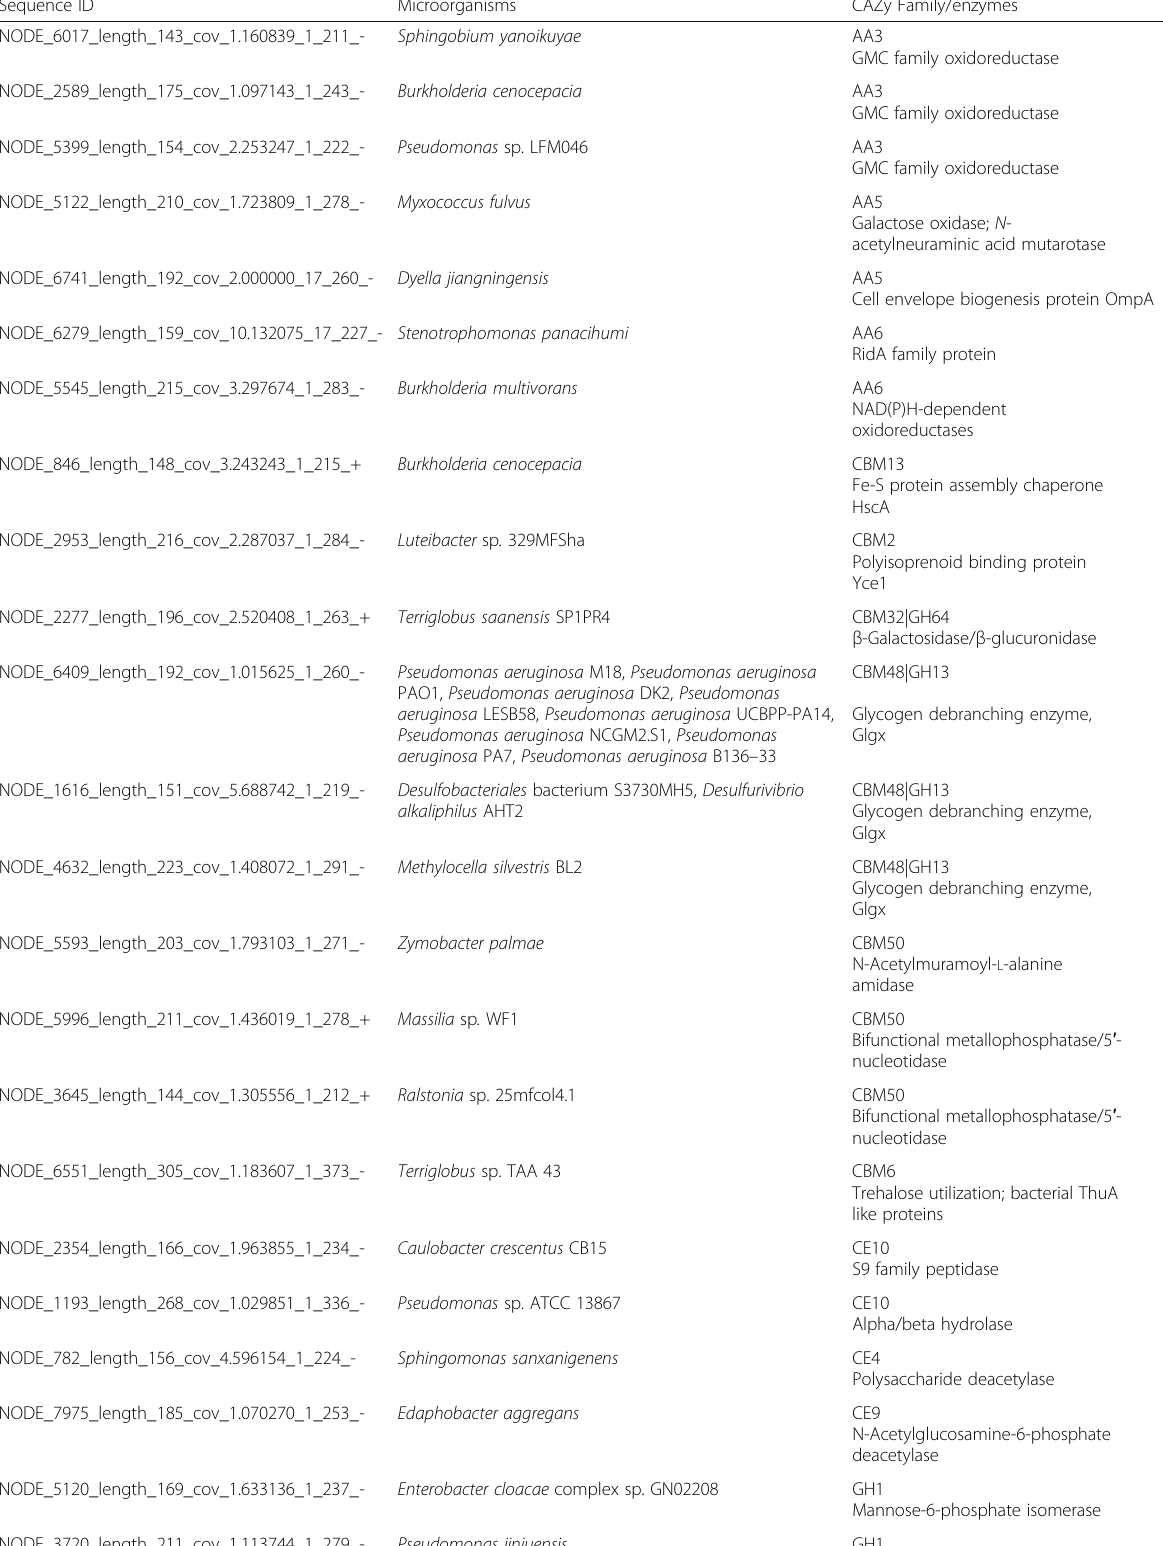
Table 2 List of AB1 microcosm sequences annotated for carbohydrate-active enzymes (CAZy) and their taxonomic affiliations Sequence